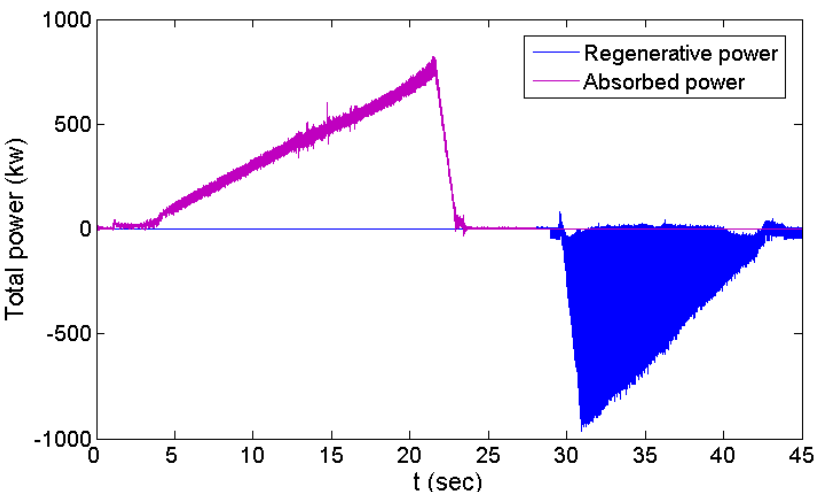
Figure 8. The experiment power diagram of one metro car.